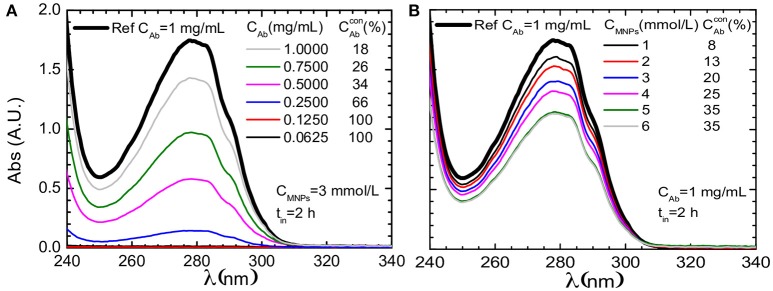
UV-vis data (focused in the range of 240–340 nm) for the supernatant of Fe3O4-DMSA-SMCC-BCZM samples that were prepared for incubation duration, time = 2 h, for six different concentrations of (A) BCZM and constant concentration of IONPs (CFNs = 3 mmol/L) and (B) IONPs and constant concentration of BCZM (CAb = 3 mmol/L). The respective curve of a reference BCZM solution (1 mg/mL) is also shown, in both cases. The CAbcon presented in both panels refers to the percentage of BCZM conjugated with the Fe3O4 IONPs, as this was estimated from the respective set of data. The supernatant of the samples was isolated when the magnetic species were trapped by means of an external magnetic field.